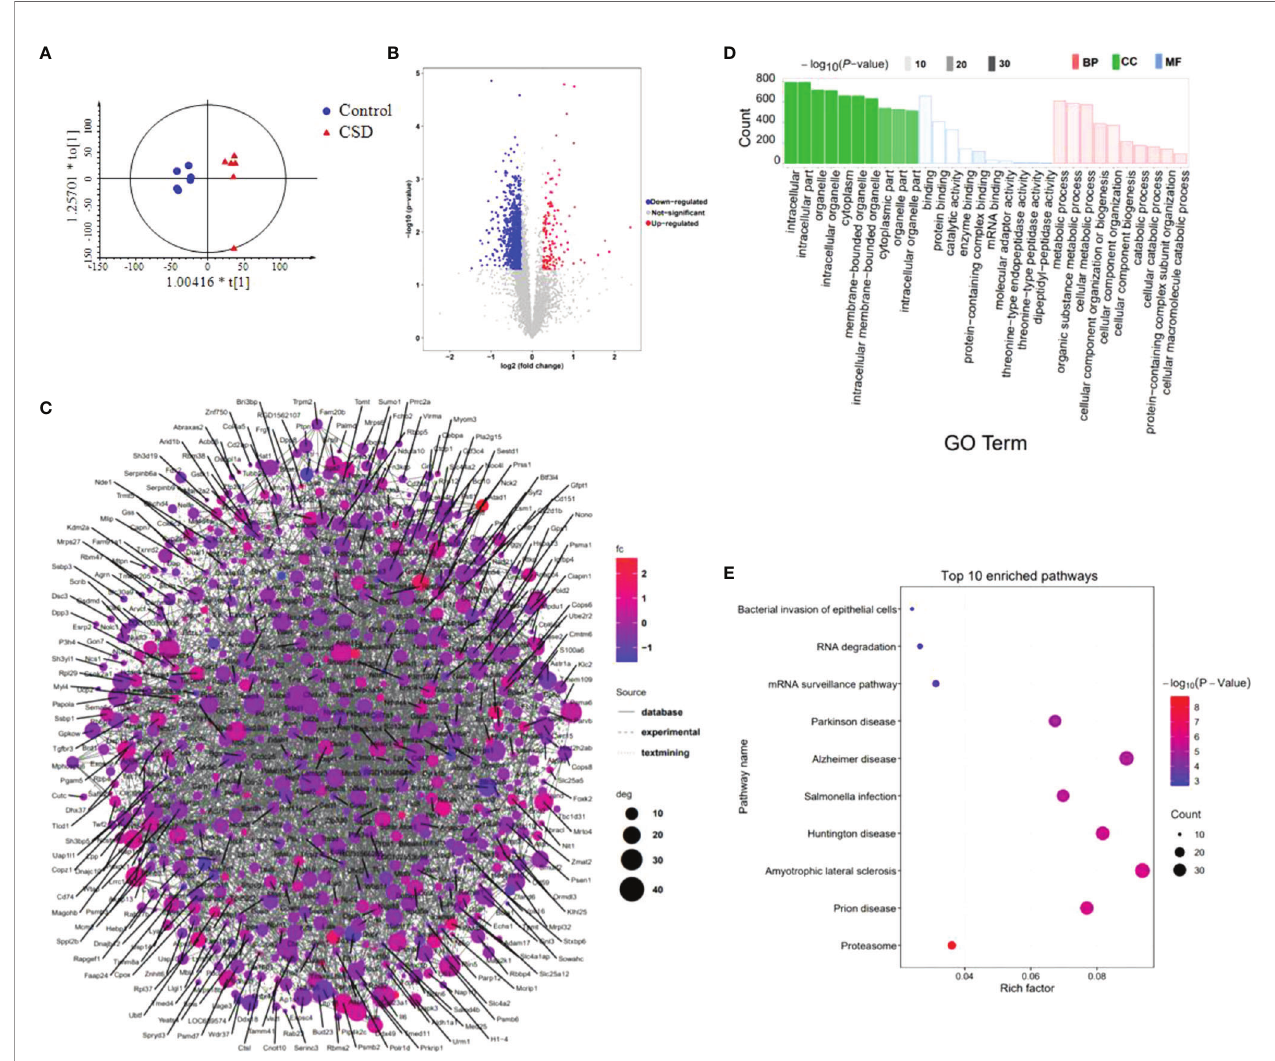
FIGURE 7 | The effects of CSD on proteomic pro fi ling of tongue tissue in rats. (A) OPLS-DA model shows a separation of clusters between the control group and CSD group. (B) Volcano plots for the control group vs the CSD group. (C) The differentially expressed proteins were searched in the STRING database to visualize potential protein networks. (D) Gene Ontology (GO) and (E) KEGG pathway enrichment analysis of the differentially expressed